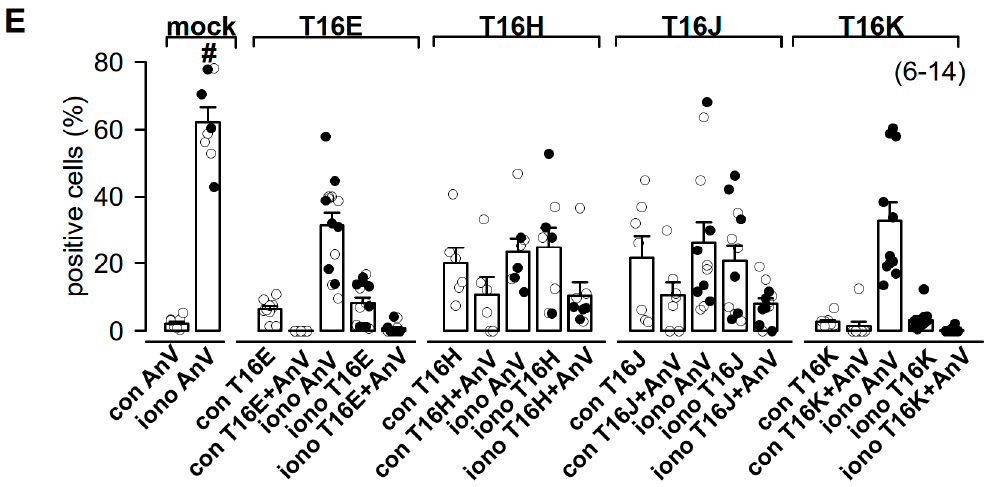
Figure 6. Plasma membrane expression of TMEM16E, -H, -J or -K was not correlated to phospholipid scrambling activity. ( A ) CFP fluorescence (green) of living HEK293 cells transfected with TMEM16E- CFP-CAAX, ( B ) TMEM16H-CFP-CAAX, ( C ) TMEM16J-CFP-CAAX or ( D ) TMEM16K-CFP-CAAX was mostly not localized with the annexin V signal (red), indicating absence of phosphatidylserine scrambling to the outer leaflet of the plasma membrane under control and after stimulation with ionomycin. Bar 20 µm. ( E ) Summary of positive cells for TMEM16 paralogs and annexin V staining under control (con) and stimulated (iono) conditions. (Number of experiments), # unpaired t-test, and analysis of variance (ANOVA), α < 0.05.